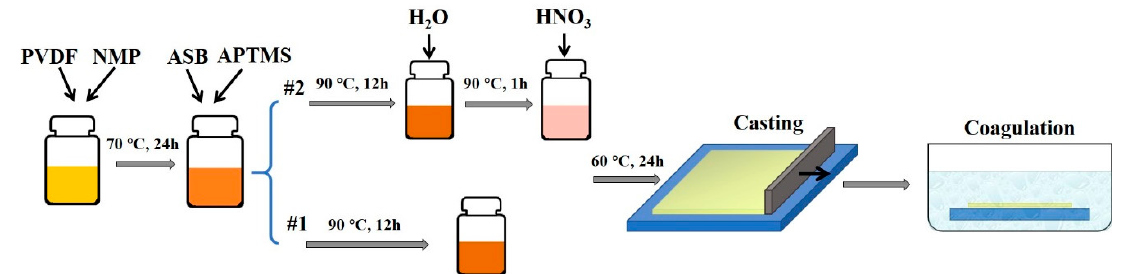
Figure 1. The fabrication process of membrane substrates.